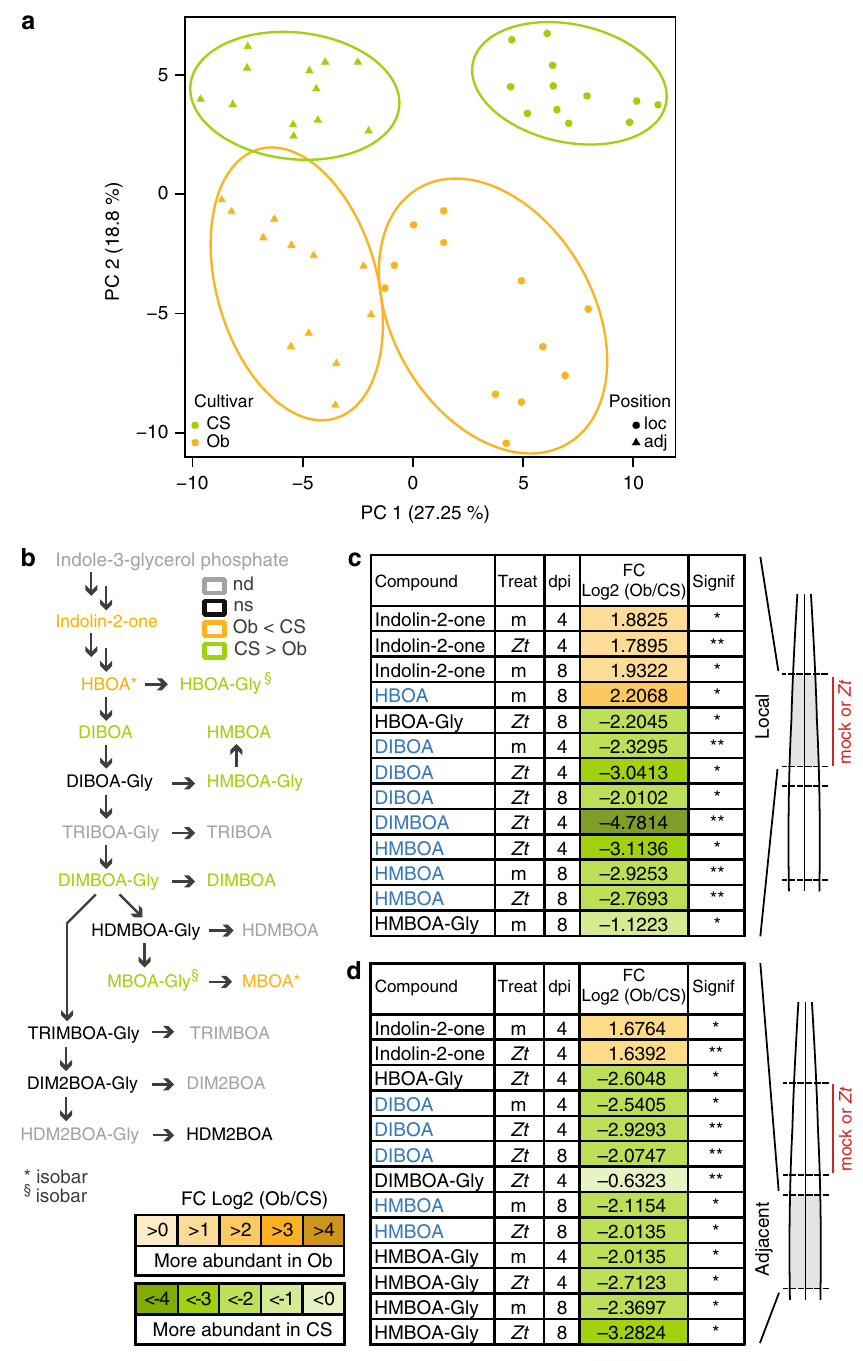
Fig. 3 Biosynthesis of benzoxazinoids is altered locally and in adjacent tissues upon infection with Z. tritici . a Principal component analysis (PCA) based on the complete metabolomics dataset. Samples are colored according to cultivar, and shapes refer to the position in the leaf. b Biosynthesis pathway of benzoxazinoids. Compounds with signi fi cant differences in the comparison between cultivars are highlighted in orange (Obelisk) or green (Chinese Spring). nd not detected, ns not signi fi cant. c Compounds of the biosynthesis pathway of benzoxazinoids with signi fi cant differences at local site of inoculation with Z. tritici ( Zt ) IPO323 or mock (m) at 4 and 8 dpi-f between wheat cultivars Obelisk and Chinese Spring. Active forms of benzoxazinoids are highlighted in blue. d Signi fi cantly different compounds in the benzoxazinoid biosynthesis pathway at an adjacent site to the inoculation in ( c ). Active forms of benzoxazinoids are highlighted in blue. Number of biologically independent replicates: n = 3. For details on the statistical analysis of the metabolomics dataset, please see the methods section. * P < 0.05; ** P < 0.01; *** P <